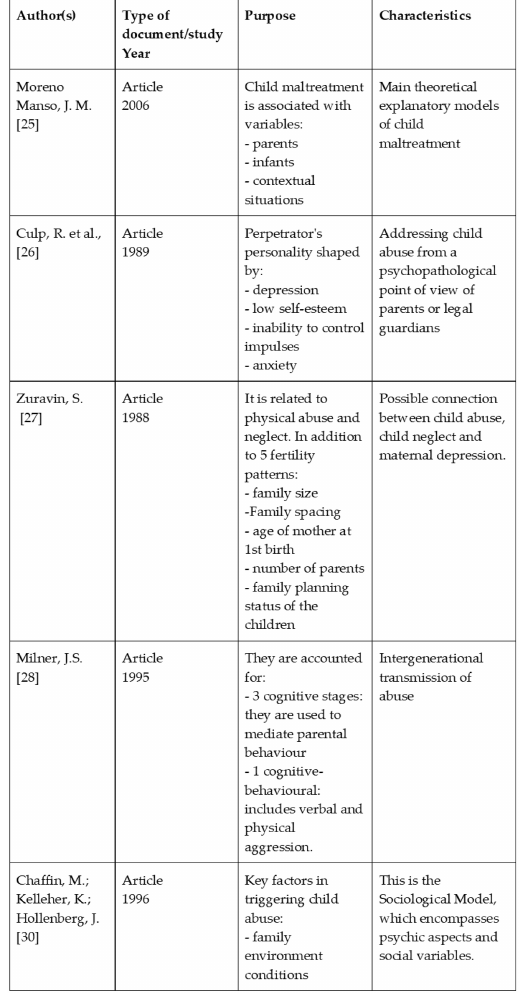
Source: Own elaboration of the authors.